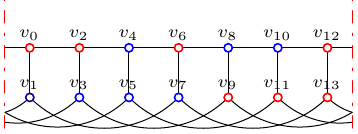
Figure 11. Segment of f in Case 1.2 in Lemma 8.